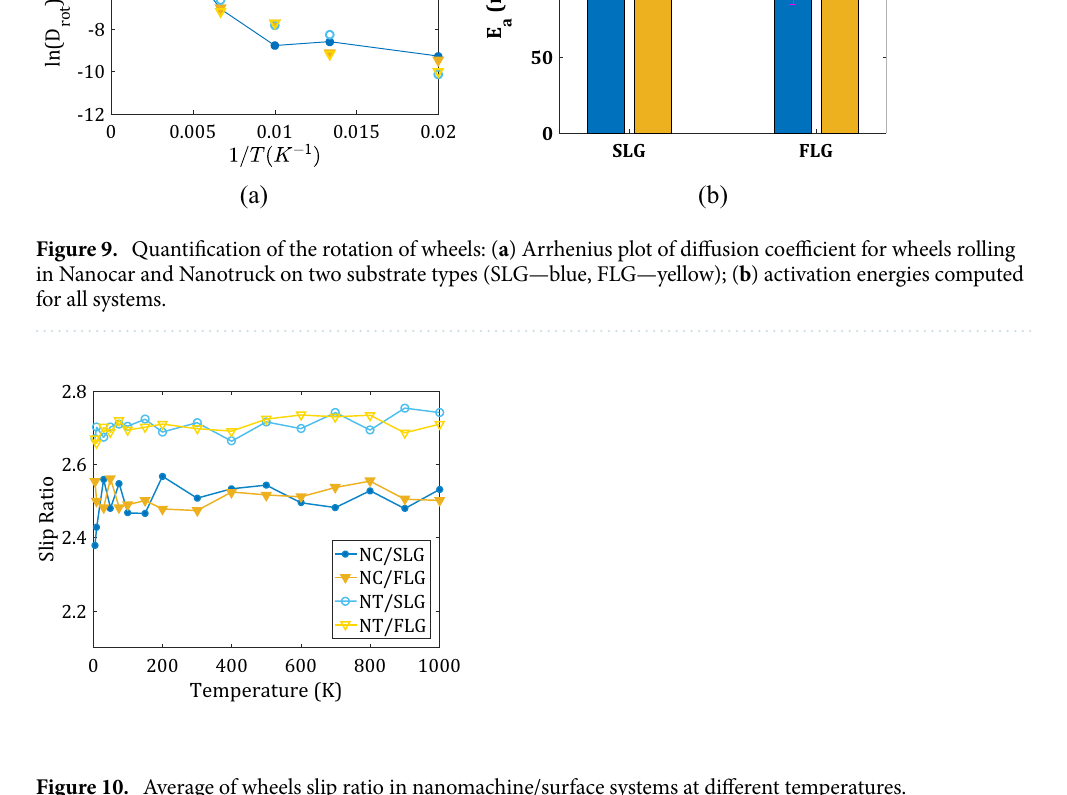
Figure 10. Average of wheels slip ratio in nanomachine/surface systems at different